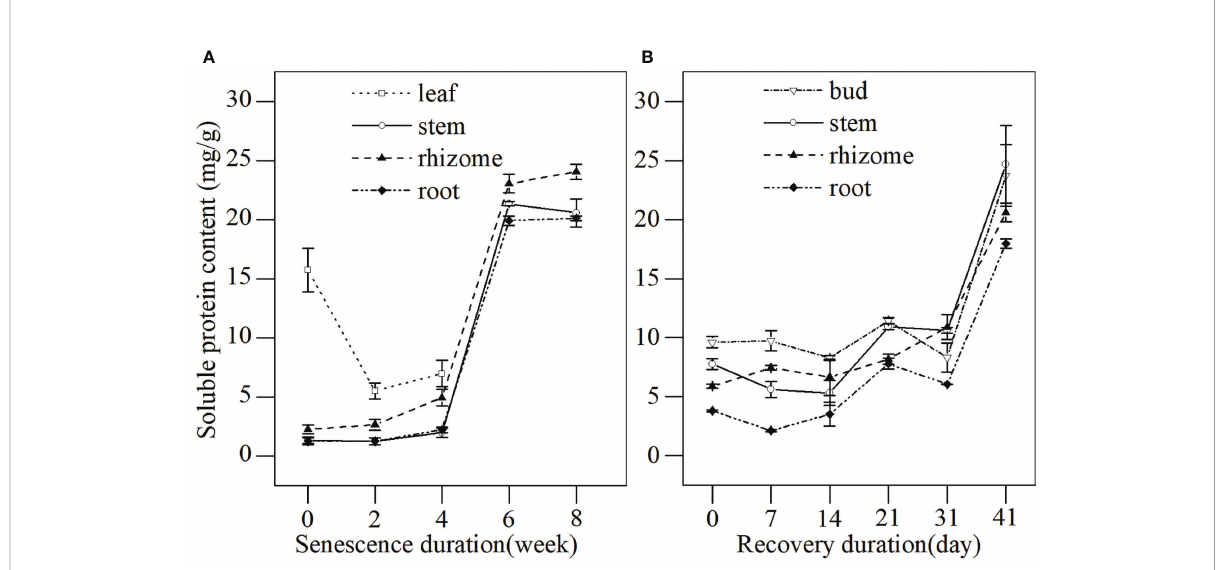
FIGURE 5 The soluble protein content in different tissues of L. japonica during senescence and the revival. Data are presented as mean ± SE. Each batch consisted of fi ve replicates. (A) Soluble protein content during senescence, (B) Soluble protein content during